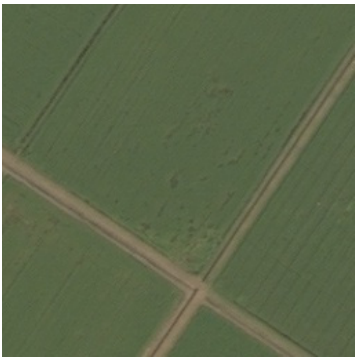
Figure 17. The image in RCC dataset.